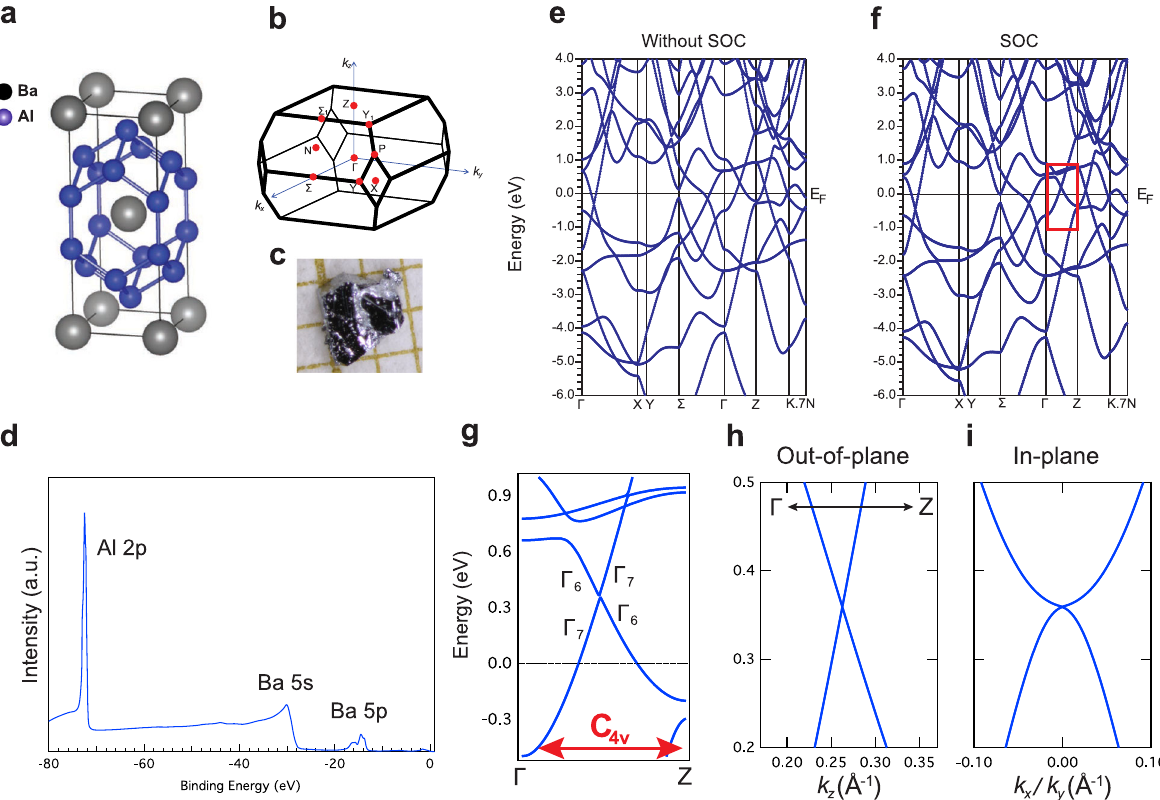
Fig. 1 Non-trivial topology of prototype compound BaAl 4 . The crystal structure ( a ) and Brillouin zone ( b ) of single-crystalline BaAl 4 ( c ) with I 4/ mmm space group are presented along with electronic structure calculations and symmetry analysis, revealing a three-dimensional Dirac spectrum with non-trivial topology. d The integrated photoemission core-level spectrum exhibits sharp peaks from Ba-5 s , Ba-5 p , and Al-2 p core-levels, con fi rming high sample quality. The calculated bulk electronic structure is presented ( e ) without spin-orbit coupling and ( f ) with spin-orbit coupling included, with red box highlighting the Γ – Z dispersion where a Dirac point is located. g Enlarged low-energy band structure with irreducible representation, where the two crossing bands belong to two different irreducible representations of the C 4 v point group, showing the accidental band crossing protected by the crystal symmetry. The zoomed 3D Dirac structure exhibits a linear dispersion along the out-of plane ( k z ) direction [panel ( h )] and a quadratic dispersion along the in-plane ( k x / k y ) directions [panel ( i )], classifying this as a semi-Dirac point where massless and massive fermions can coexist at the same point in momentum space (see